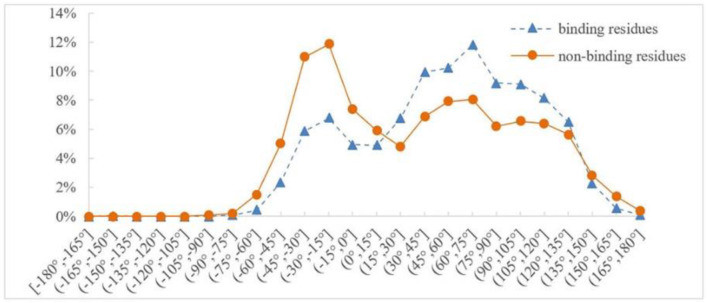
Distribution of psi angle for binding and nonbinding residues of Mn2+ ligand. The abscissa represents 24 classification intervals; the ordinate represents the percentage of predicted psi angle that appears in each interval.